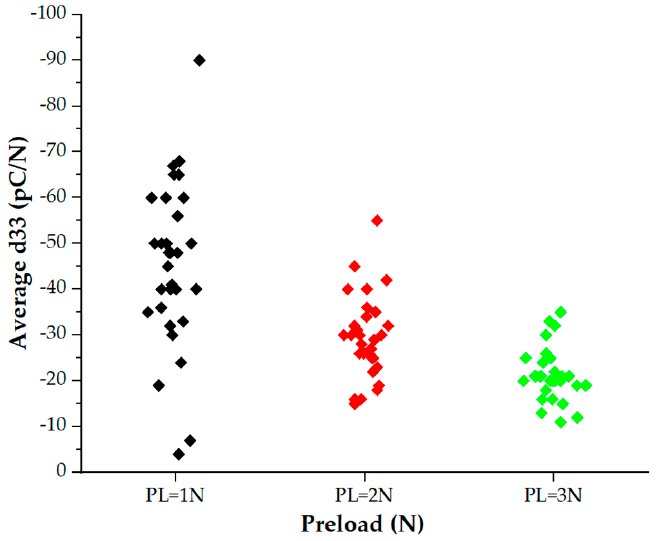
Figure 15. Average d 33 vs. preload. Sensors belonging to categories 1 and 4, only. To avoid dot superposition, values associated with the same preload are plotted such that dots do not lie on the same vertical line.